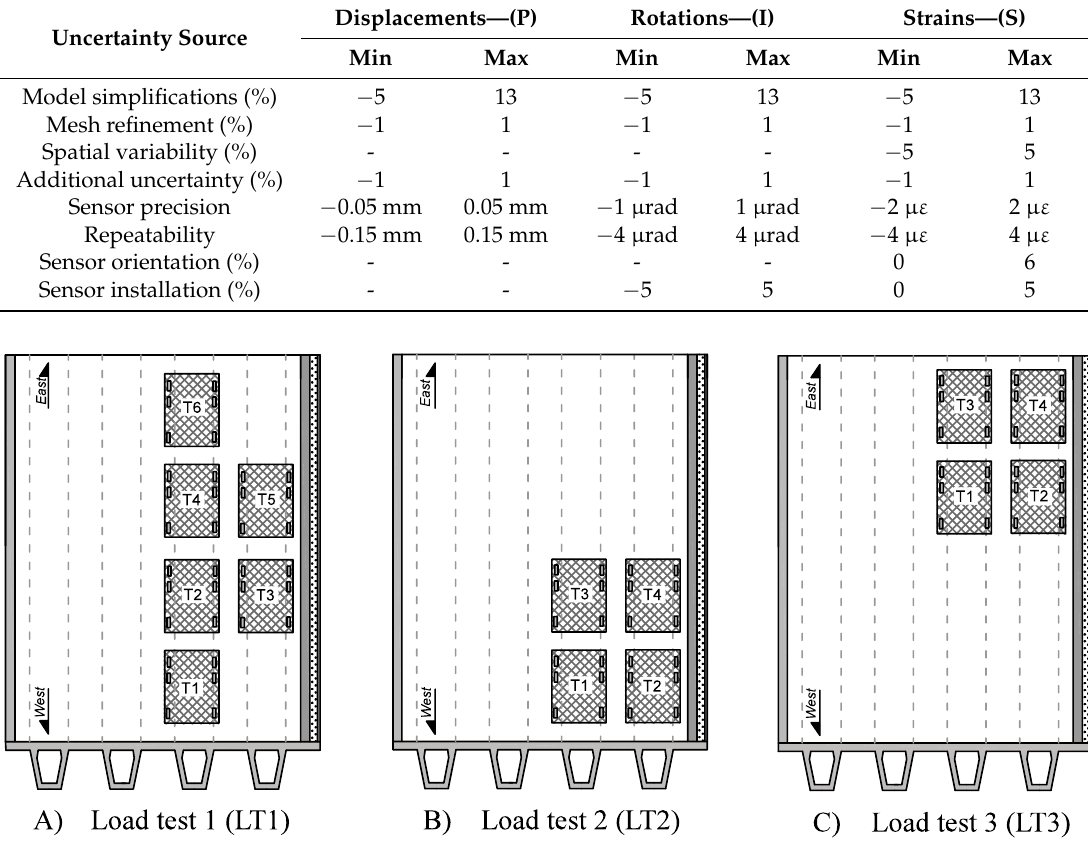
Figure 7. Load test presentation; ( A ) first load test; ( B ) second load test; ( C ) third load test.